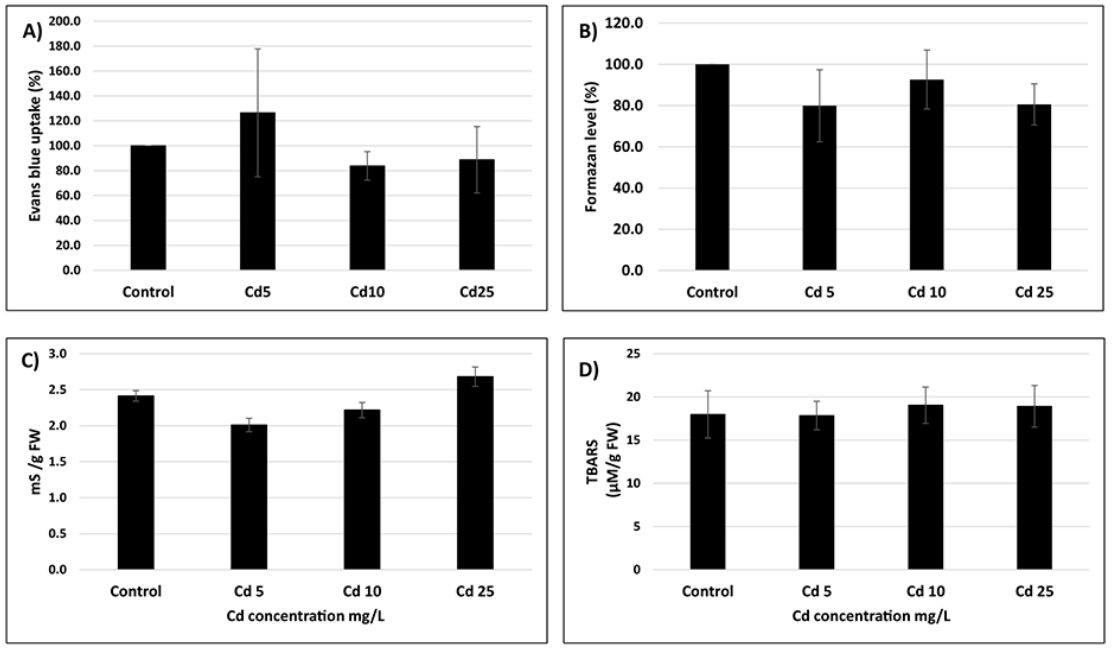
Figure 2 Amount of dead cells expressed as % of the level of Evans blue ( A ) or tetrazolium chloride ( B ) changes in electrolyte leakage ( C ) and thiobarbituric acid reactive substances level ( D ) in seeds exposed to Cd at concentration 5 (Cd 5), 10 (Cd 10), and 25 (Cd 25) mg/L. The results are means of three–five independent repetitions ± SE . No significant differences were